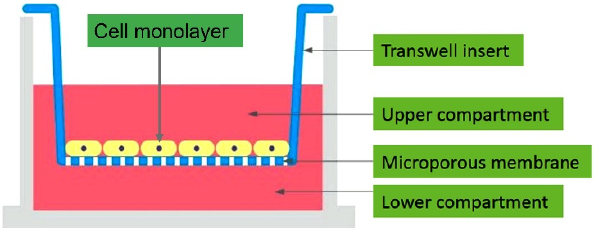
Figure 1. The overview of a transwell support system (taken from https://tumomics.creative-proteomics.com/, accessed on 28 June 2021, with permission).